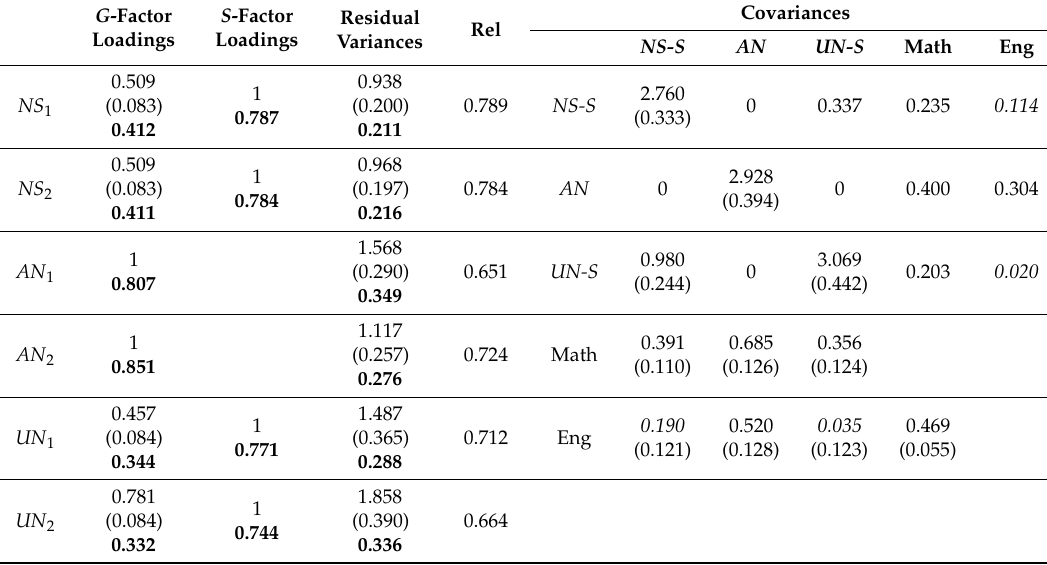
Table 6. Bifactor( S -1) Model with Correlated First-order Factors and